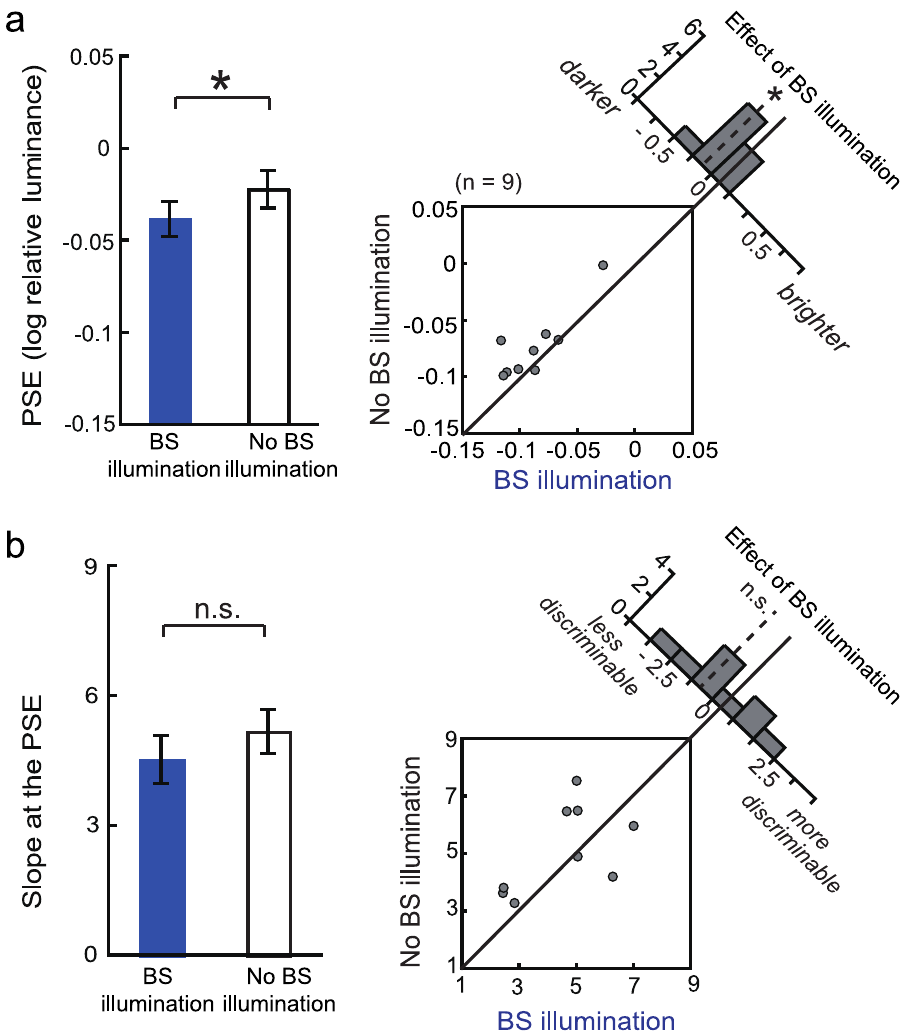
Figure 4. Results of Experiment 2 confirming brightness decrease by the blind-spot illumination despite the control of light leakage. ( a ) Point of subjective equality (n = 10; mean ± standard error). Conventions are the same as those in Fig. 2a. * p < 0.05. ( b ) Slope of the psychometric function. Conventions are the same as those in Fig. 2b. Also see Supplementary Fig.